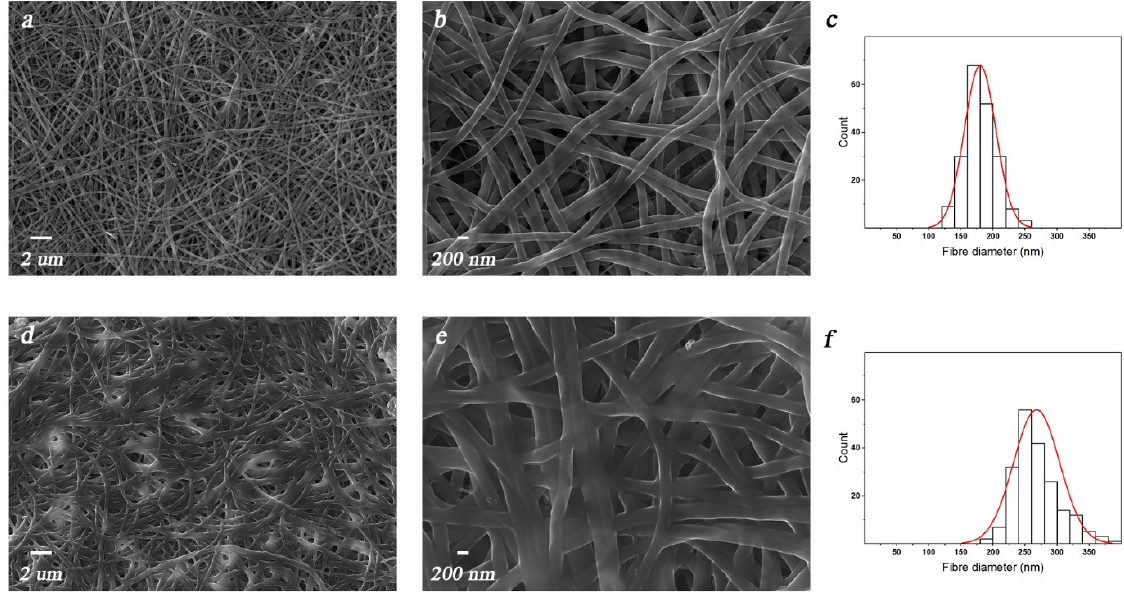
Figure 3. FESEM micrographs for chitosan membranes after ( a , b ) a physical or ( d , e ) a chemical crosslinking treatment and ( c , f ) their related size histograms .